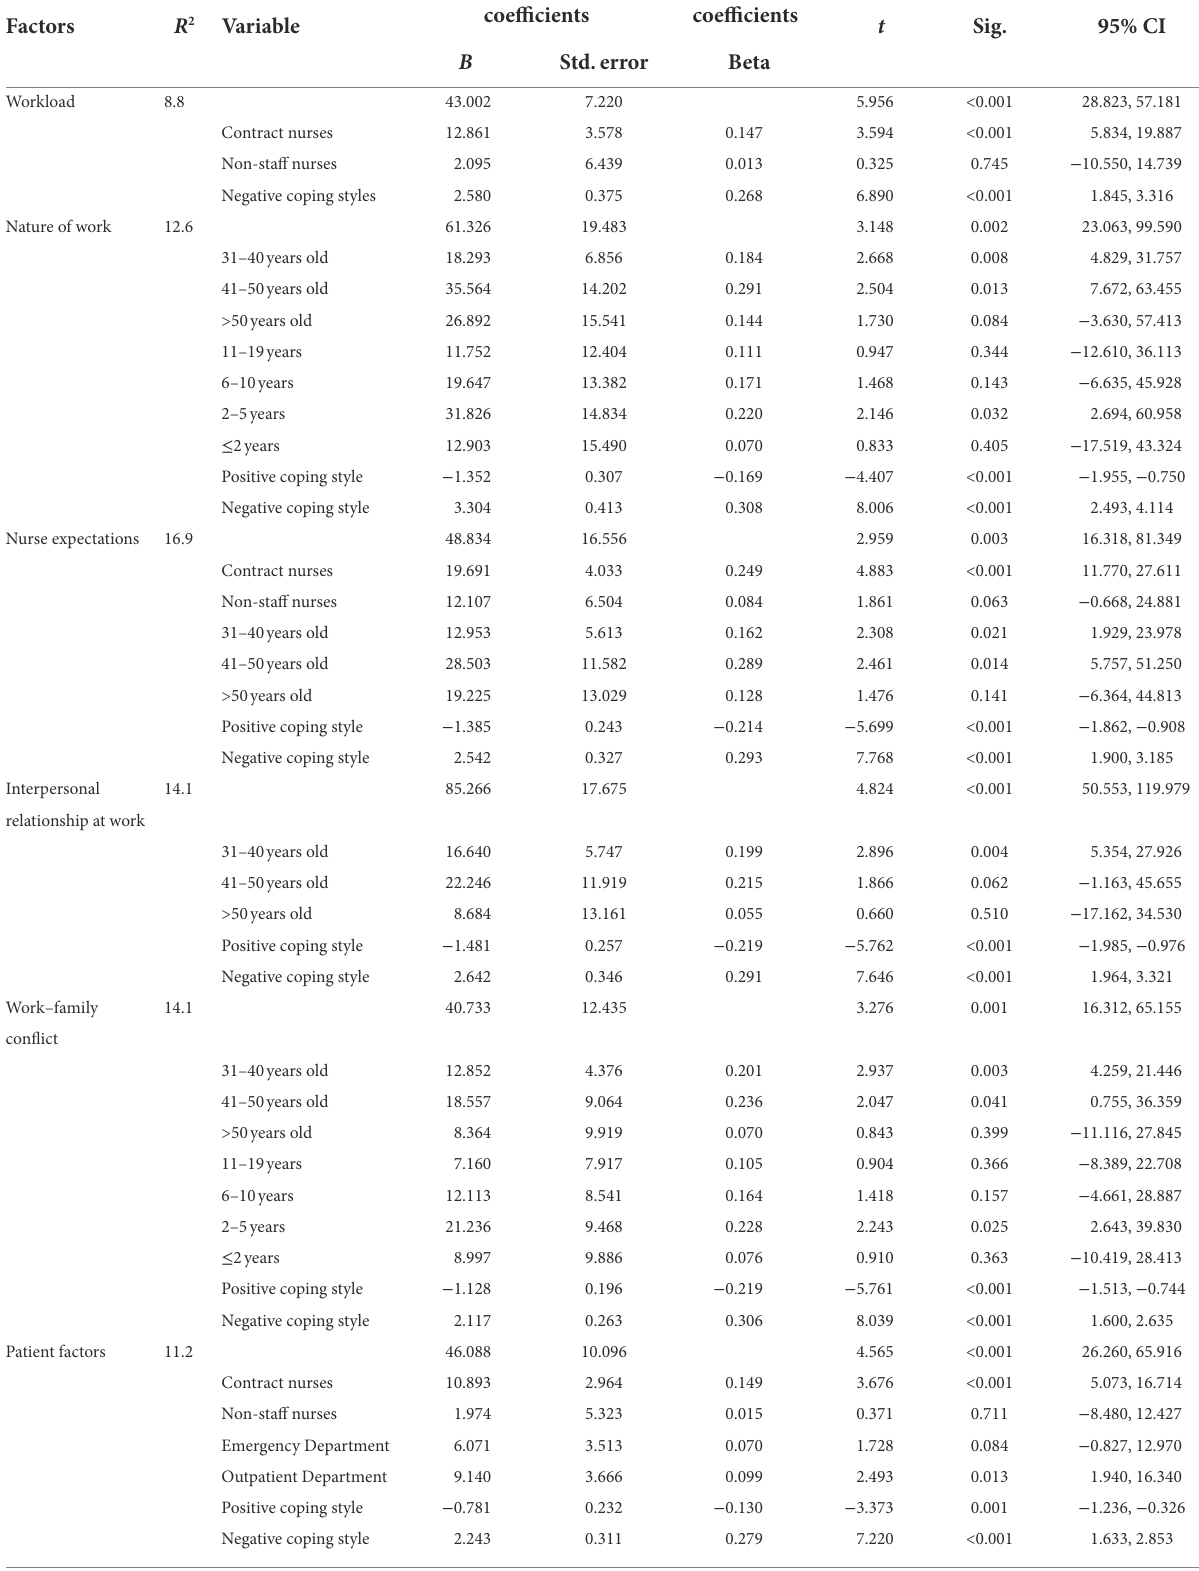
TABLE 5 Multiple regression results of stressors for workload, nature of work, nurses’ expectations, interpersonal relationships at work, work– family conflict, and patient factors.